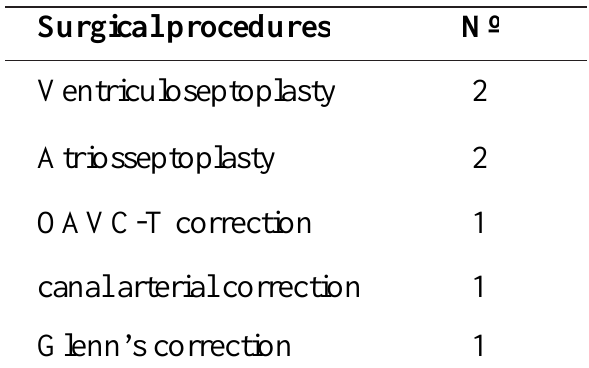
Table 1. Group I: Congenital heart disease